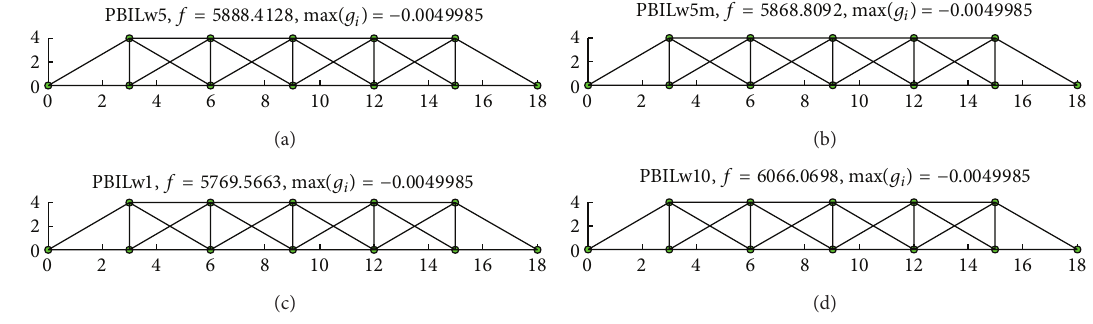
Figure 7: Optimum structures of AOP3 from various